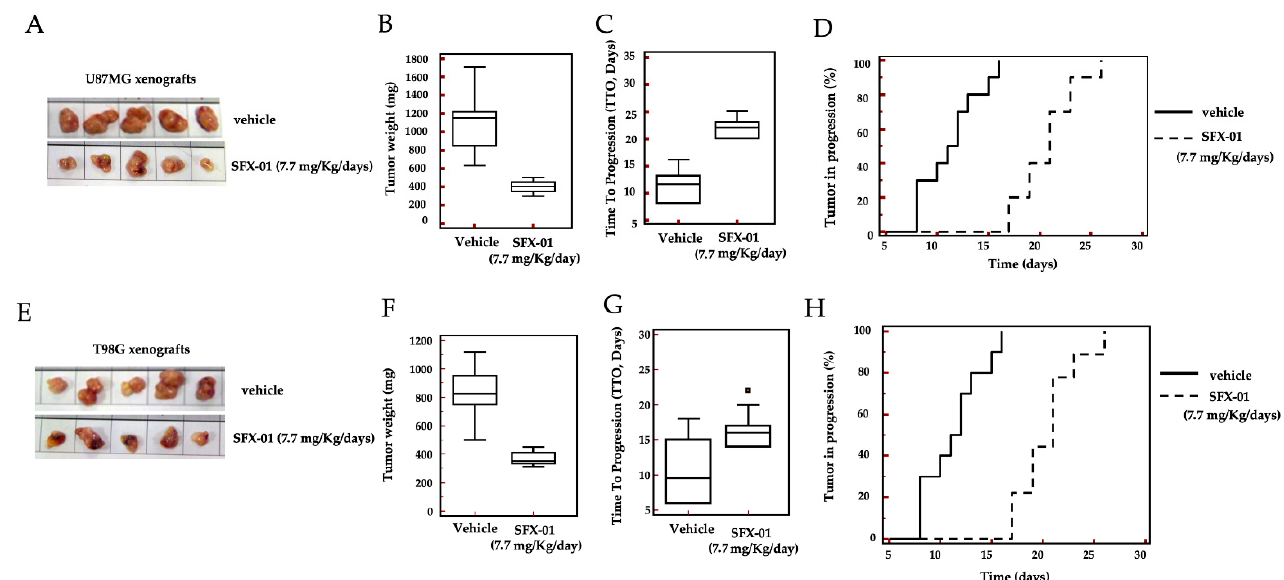
Figure 7. In vivo experiments: SFX-01-mediated tumor growth reduction and radio-sensitization of U87MG and T98G xenografts. Each experimental group is represented by five mice with two tumors in the flank: ( A ) Five representative tumors harvested from U87MG xenografts (control and after treatments). ( B ) Quantification of tumor weights in 10 tumors harvested from treated and untreated animals. Statistical analysis is shown in Table I. ( C ) Tumor to progression (TTP) analysis. ( D ) Percentage of mice in progression plotted for the time (Kaplan-Meier curves). Analysis of Kaplan-Meier curves demonstrated that SFX-01 reduced the tumor progression rate of U87MG. ( E ) Five representative tumors harvested from T98G xenografts (control and after treatments). ( F ) Quantification of tumor weight in 10 tumors harvested from treated and untreated animals. Statistical analysis is shown in Table I. ( G ) Tumor to progression (TTP) analysis. ( H ) Percentage of mice in progression plotted for the time (Kaplan-Meier curves). Analysis of Kaplan-Meier curves demonstrated that SFX-01 reduced the tumor progression rate of T98G. Statistics are indicated in the Supplementary Data, Table S1. Table 1. Statistical analyses of tumor weight and Time to Progression in U87MG and T98G xeno- grafts.